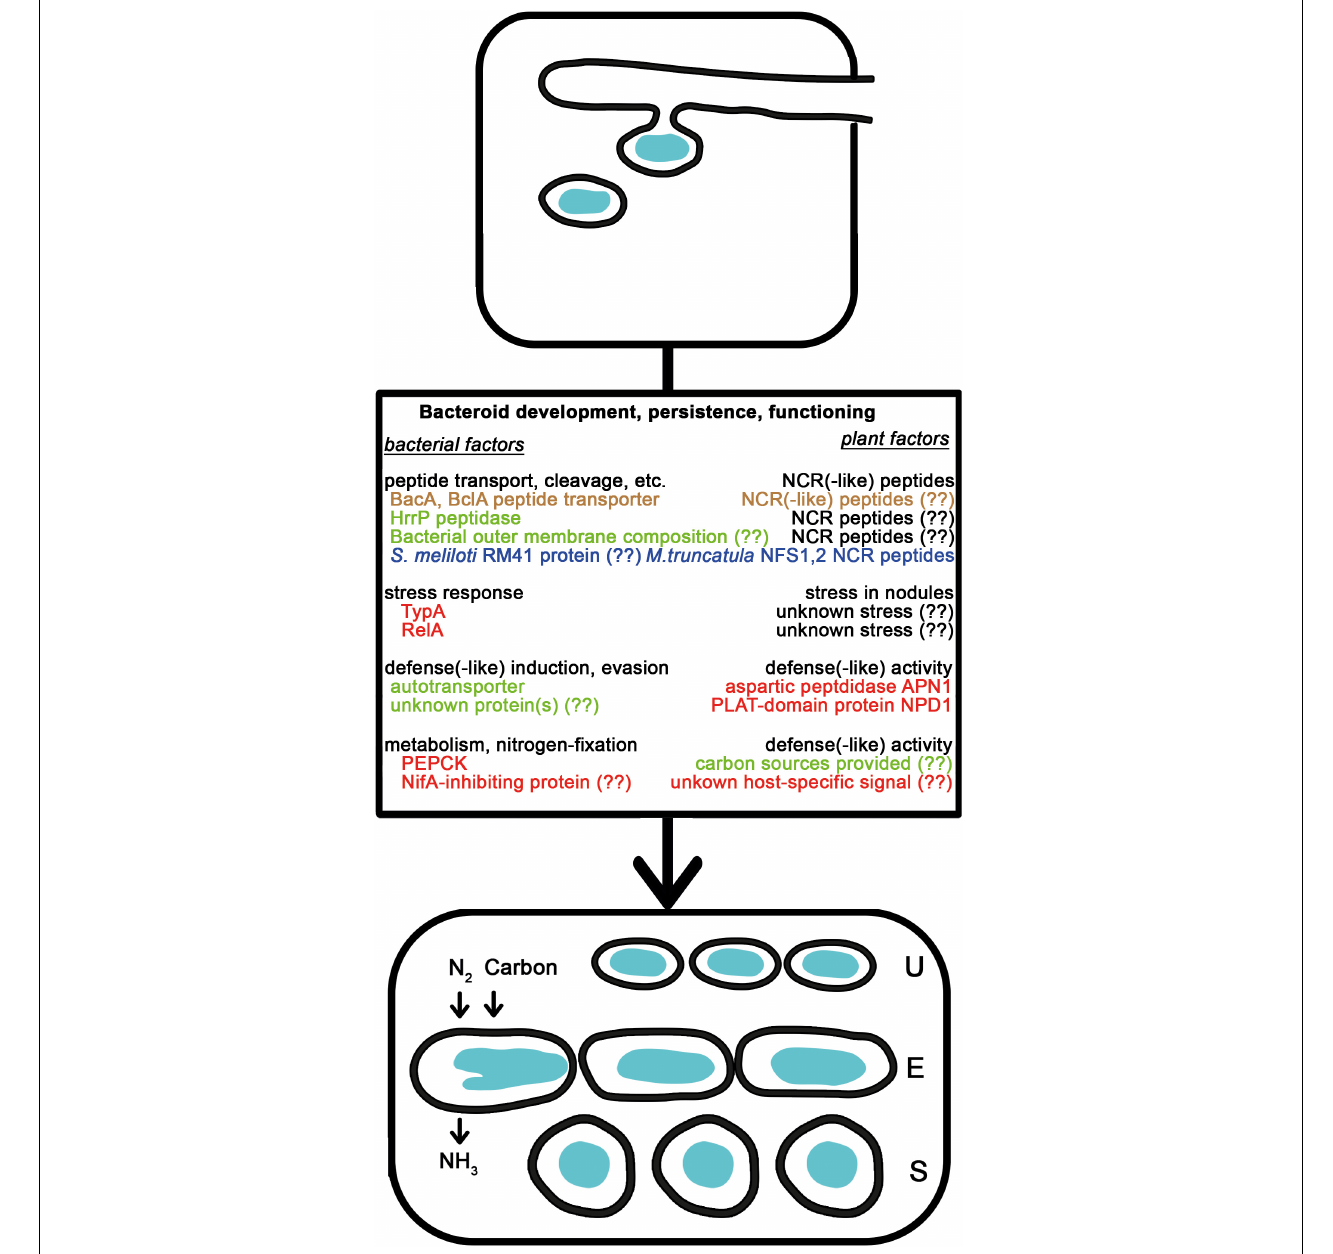
FIGURE 2 | Natural variations affecting bacteroid development, persistence, and functioning. After the release of rhizobia from the ITs, bacteria differentiate into nitrogen-fixing bacteroids of unmodified (U), elongated (E), or spherical (S) morphotypes. The NCR peptides affecting bacterial membrane and intracellular functions are delivered into bacteria by peptide transporters and contribute to the terminal differentiation of E and U morphotype bacteroids. Bacterial outer membrane composition, peptidases and independently evolved transporters affect the success of bacteroid development. The NCR peptides are also involved in strain discrimination. The level of stress and the available carbon sources in the plants affect how bacteria with mutations in stress related genes or carbon metabolism perform. Bacteria also might induce and endure plant defense reactions and sense signals from certain plants that affect gene expression. Colors are the same as in Figure 1